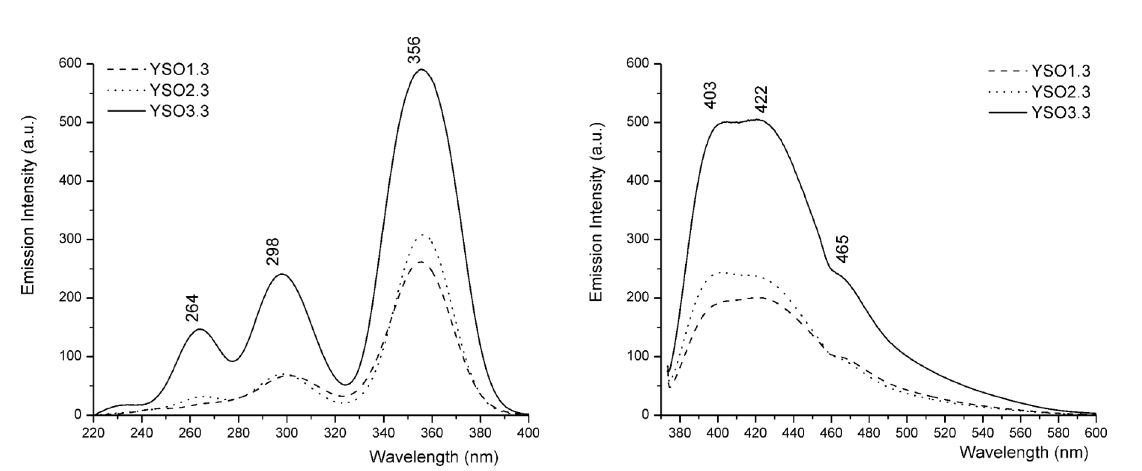
Figure 8. Excitation spectra (left) λ